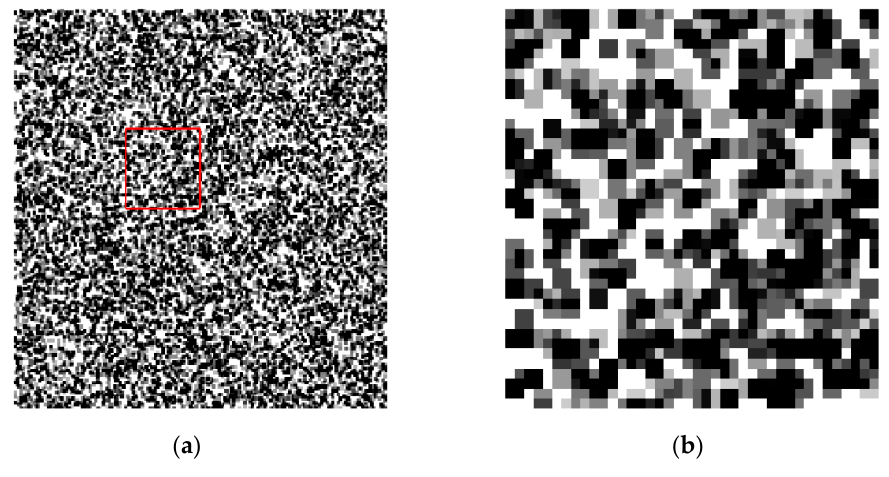
Figure 1. Speckle pattern generated using MATLAB. ( a ) Complete pattern and ( b ) magnified view of area highlighted in ( a ).